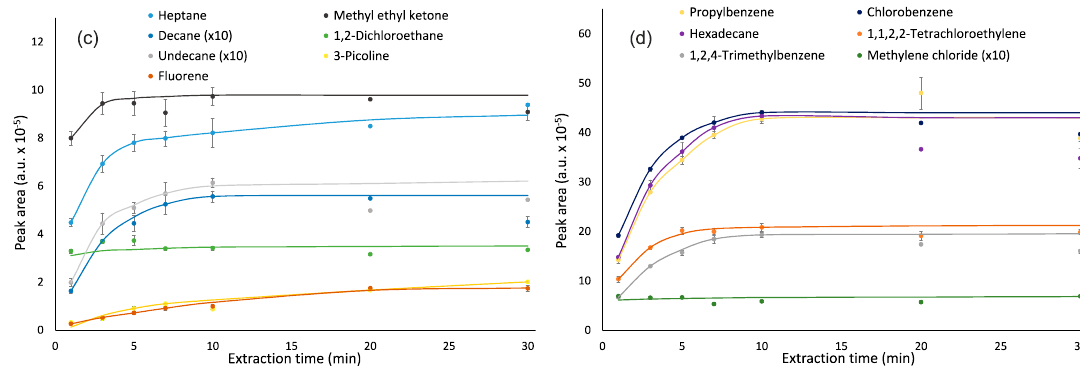
Figure 1. Effect of extraction time on responses of analytes: ( a )—benzene, toluene, ethylbenzene,